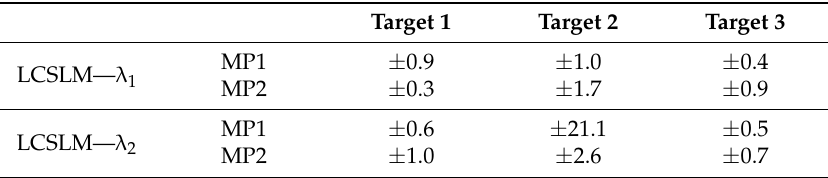
Table 3. Uncertainty U ( σ o = R q,o ) of the experimental results in